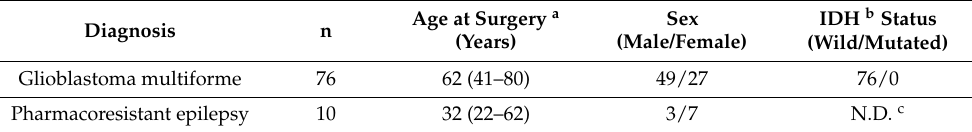
Table 1. Characteristics of patient